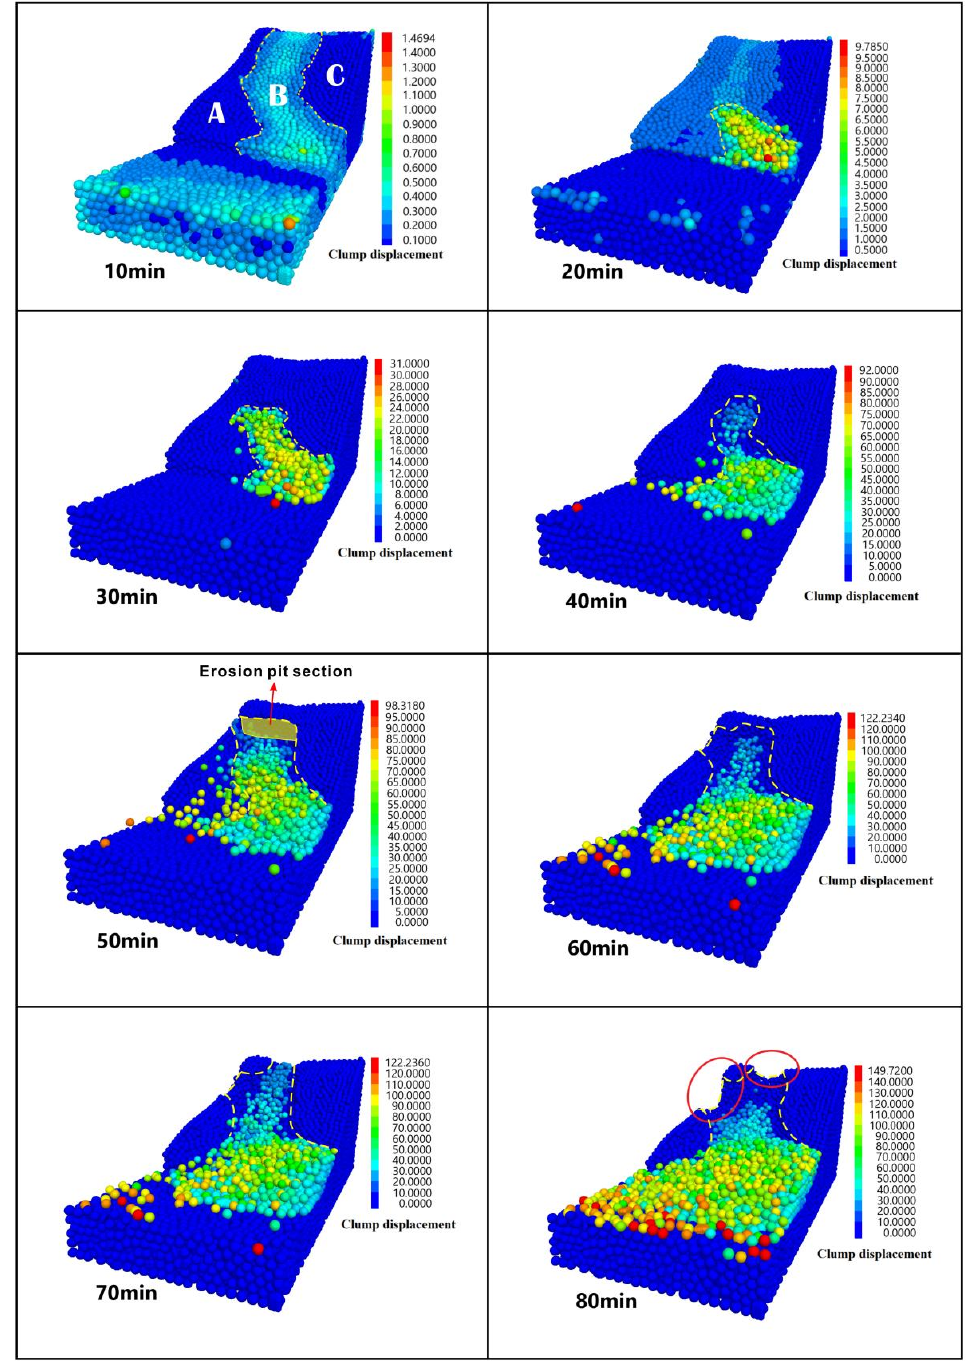
Figure 11. Gully formation process. ( A-Catchmentarea; B-Rainfallscouring area; C-Catch-